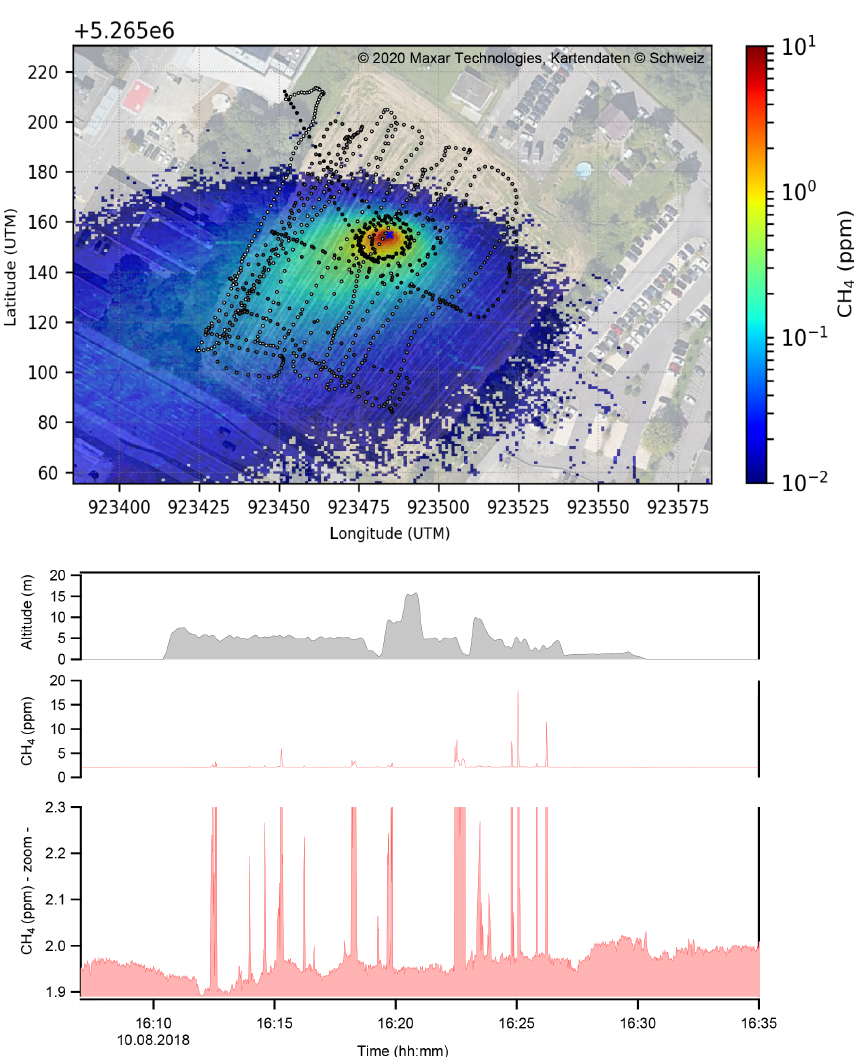
Figure 7. Satellite image of the area used for controlled surface release with the artificial CH 4 source, indicated by the blue cross, with the flight tracks superimposed on the simulated footprint emission map (top). Time series (time zone: CET) of the retrieved CH 4 concentrations with a zoom-in around the background level (bottom). The in-flight period can be easily deduced from the altitude plot